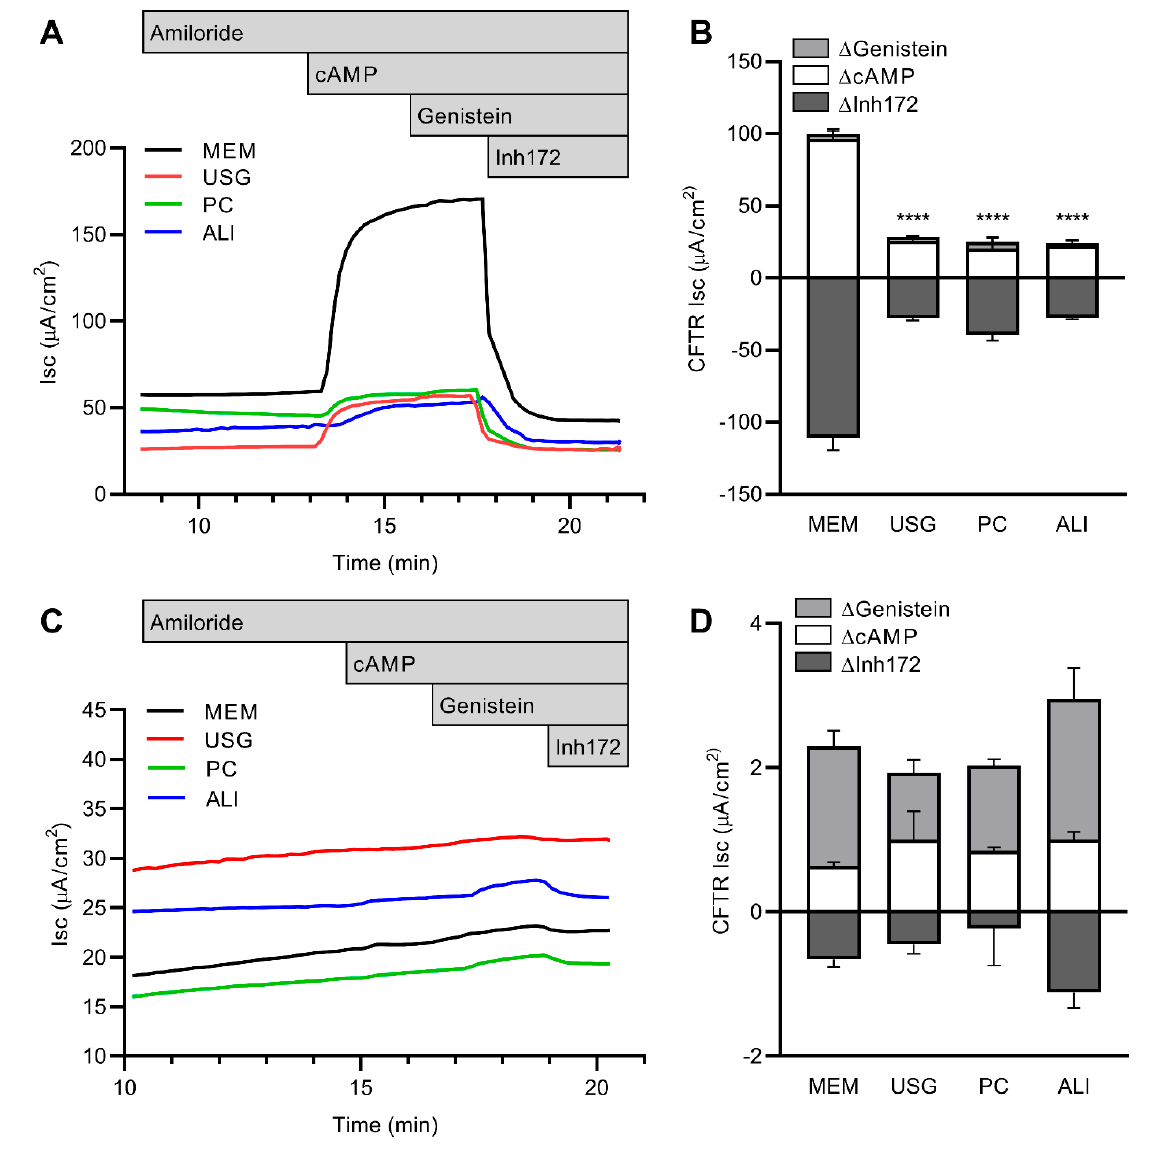
Figure 4. Media selection impacts wtCFTR but not F508del CFTR function in CFBE41o- cells. Cells grown in four media were mounted in Ussing chambers and CFTR function was quantified under voltage clamp conditions. In wtCFTR+ cells, significantly higher CFTR function was present in cells grown in MEM (representative Ussing tracings in ( A ); aggregate data in ( B )), while this differential function was not noted in F508del CFTR+ cells (representative Ussing tracings in ( C ); aggregate data in ( D )). White bars— ∆ cAMP; light grey— ∆ Genistein; dark grey— ∆ Inh172. n = 3–4 inserts per condi- tion. **** p < 0.0001 vs. MEM by one-way ANOVA with Dunnett’s multiple comparisons